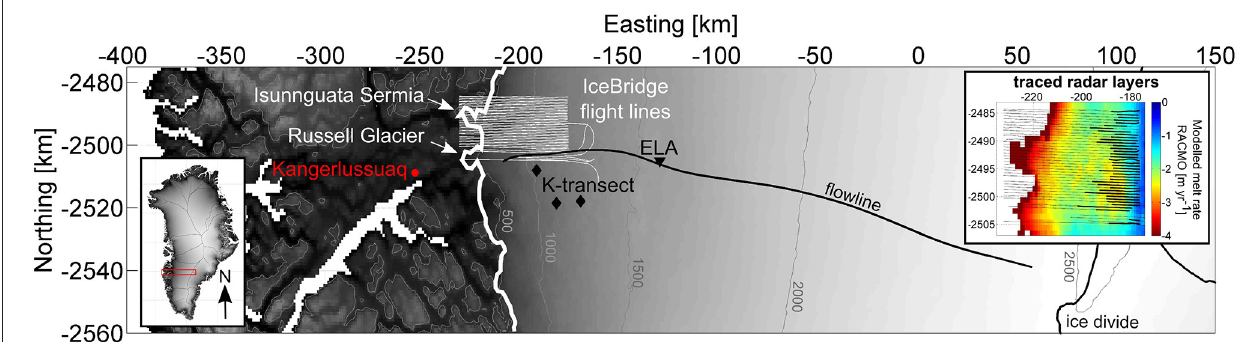
FIGURE 1 | Study area in western Greenland. Shown with ice surface elevation contours in meters above sea level (gray lines and shading; data by Bamber et al., 2013) and the ice divide (thick white line; data by Zwally et al., 2012). Inset shows the location of the study area (red) within context of the entire Greenland Ice Sheet. This and all subsequent figures use geographic coordinates in polar stereographic projection (true latitude 70 ◦ , central meridian − 45 ◦ ). The outlet glaciers Isunnguata Sermia and Russell Glacier are indicated (white arrows). Location of IceBridge flightlines (thin white lines), K-transect surface mass balance sites (black diamonds), the modeled ice flowline (black line), and the Equilibrium Line Altitude (ELA; black triangle), are also shown. The extents of traced radar layers used to calculate radar-derived mass conserving (rMC) ablation rates are shown on the zoomed inset of IceBridge flightlines (bold black lines), plotted over surface mass balance output from the regional climate model RACMO (gridded, colored cells; data by Noël et al.,